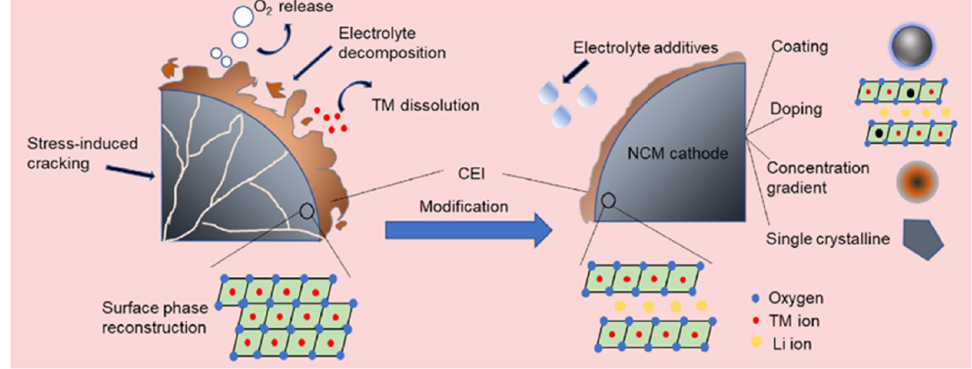
Figure 2. The diagrammatic illustration of remaining issues and modification strategies for nickel-rich NCM, reproduced from Ref. [186]. Copyright 2020, Wiley.